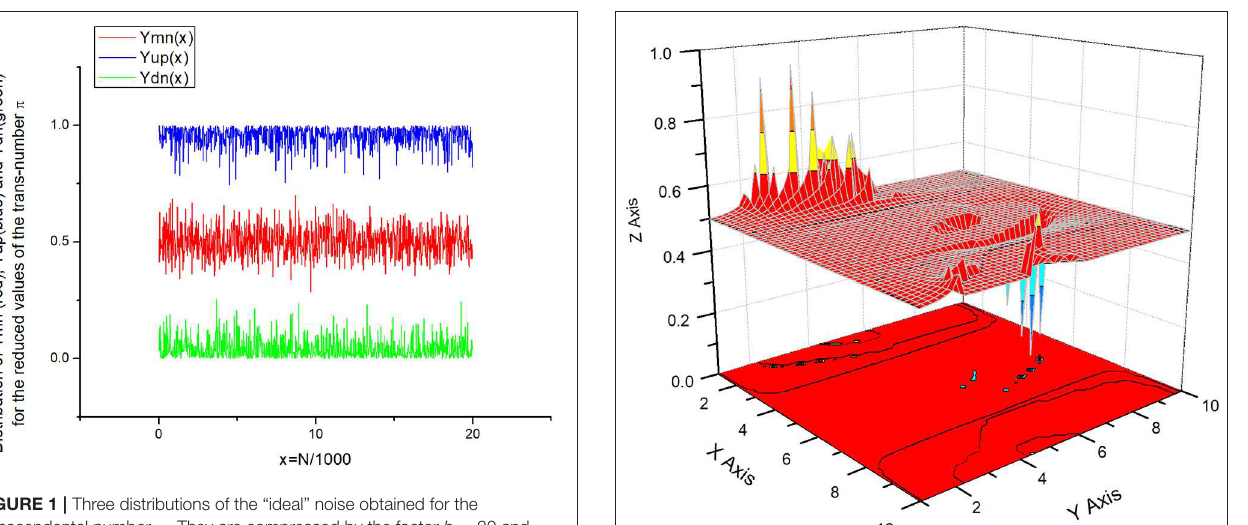
The two unknown parameters R (1,2) , R (1,3) from (6) can be expressed in an explicit